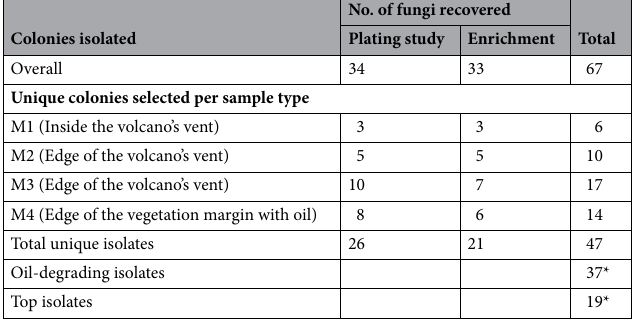
Table 1. MV sampling and fungal isolation data from the four geographically separated sites. *One isolate is a yeast-bacterium